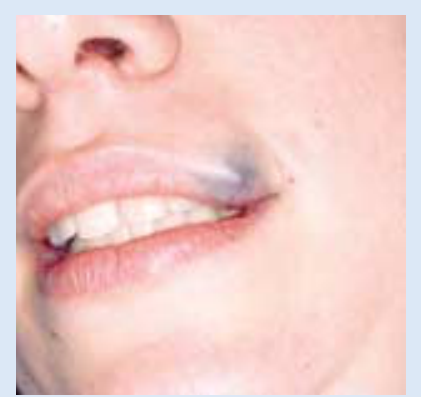
Fig. 3a. Small venous malformation of an upper lip. Note the characteristic bluish colouration.